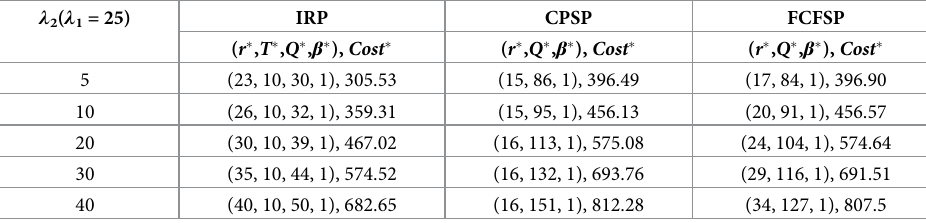
The � in the table represents the optimal